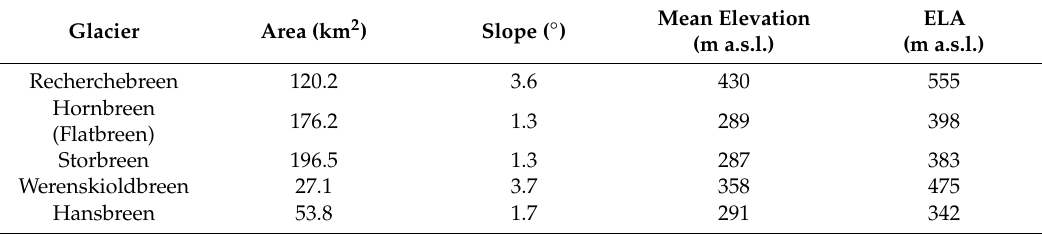
Table 2. Sample names and coordinates of the coring sites. Fe classes are determined subjectively, to illustrate proportion of ferrous to ferric minerals in the dust samples as interpreted from magnetic susceptibility κ (L denotes low κ ; H denotes high κ ). Coordinates in Universal Transverse Mercator (UTM) 33X.